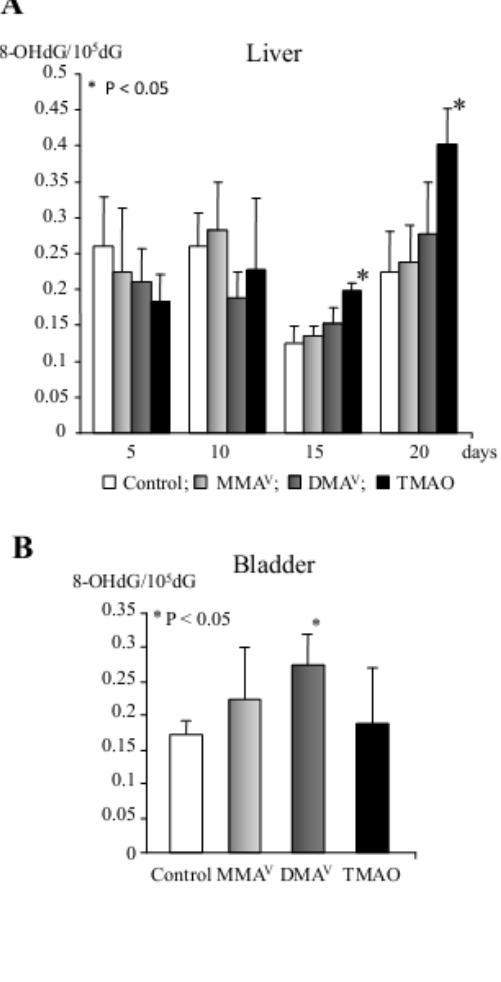
Figure 3. 8-OHdG formation in the rat liver ( A ) and bladder ( B , 20th day only) after MMA V , DMA V and TMAO